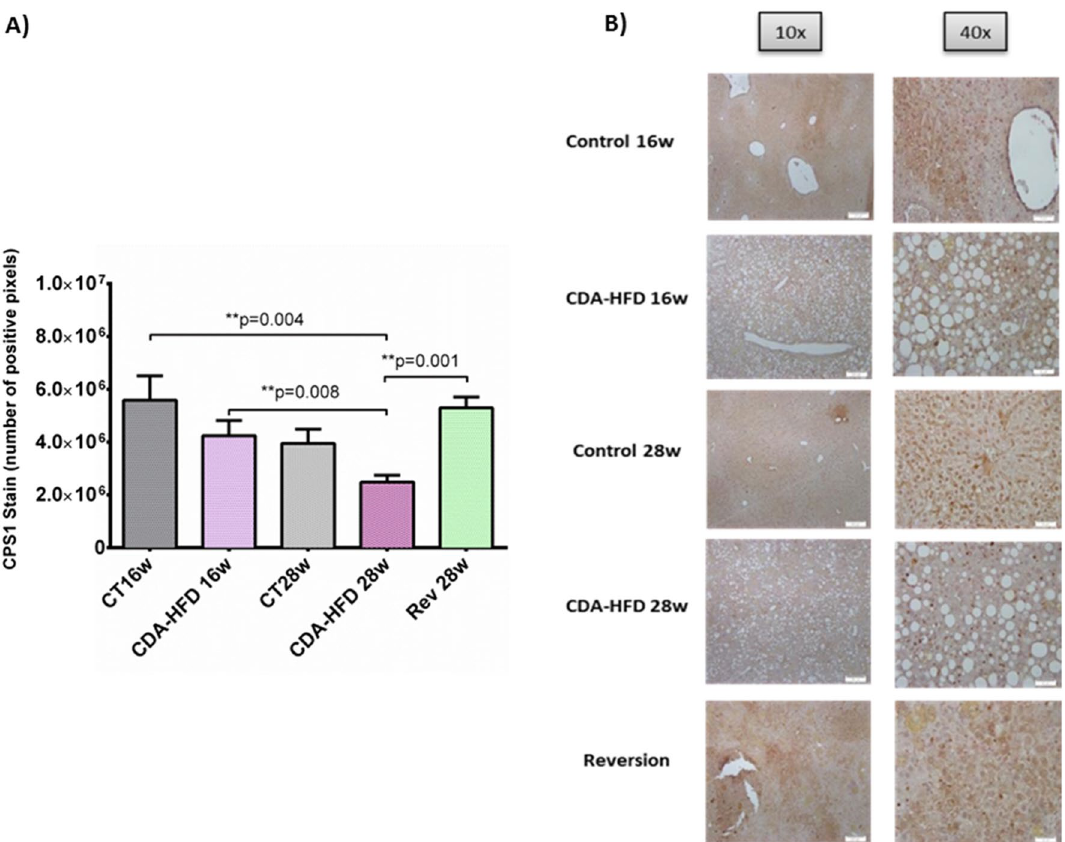
Figure 4. CPS1 findings in CDA-HFD animals. ( A ) represents the number of positive pixels quantified by ImageJ and ( B ) shows the staining. CPS1: carbamoyl phosphate synthetase-1; CT: Control; CDA-HFD: choline deficient high-fat diet; Rev: reversion.